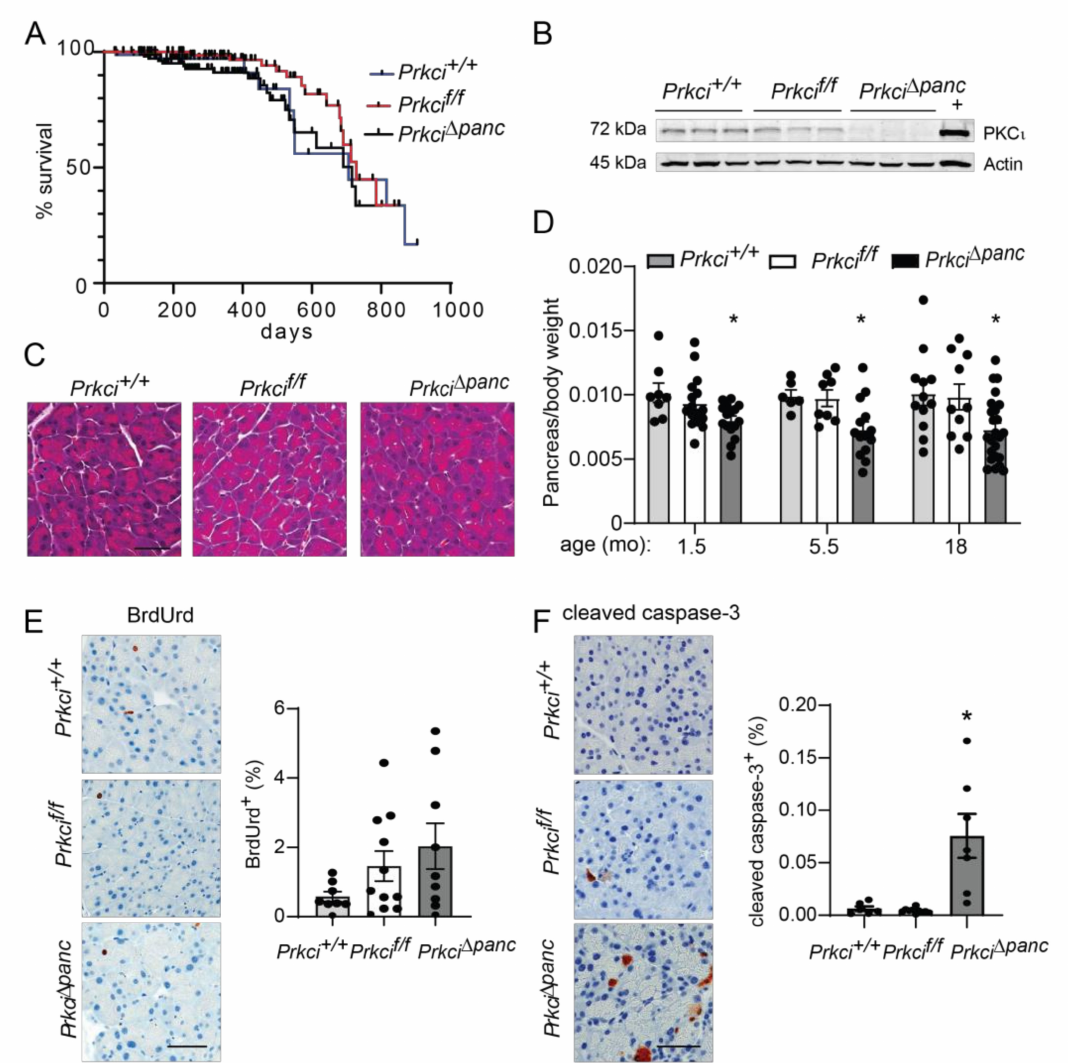
Figure 1. Characterization of pancreas-specific Prkci knockout mice. ( A ) Kaplan-Meier analysis of the overall survival of the control ( Prkci +/+ ), Prkc f/f , and Prkci ∆ panc mice is plotted. n = 81, 97, and 112, respectively. ( B ) Immunoblot analysis of PKC ι protein expression in mouse pancreas (3 representative mice/genotype). Full immunoblots are in Figure S2. ( C ) Representative H&E stained pancreas from each genotype (3.5 month old). Scale bar = 50 µ m. ( D ) The ratio of pancreas weight/body weight at harvest at indicated ages is plotted. Representative images of IHC detection and quantitative analysis of IHC staining of ( E ) cellular proliferation (BrdUrd incorporation) and ( F ) apoptosis (cleaved caspase- 3) in mouse pancreas. Analyses were performed on mice harvested at 1.5 months of age, except as otherwise described. Scale bars = 50 µ m. Quantification of pancreas weight/body weight ratio, cleaved caspase-3 expression, and BrdUrd incorporation is plotted as mean ± SE; n ≥ 6 mice/group. * p < 0.05 compared to Prkci +/+ and Prkci f/f